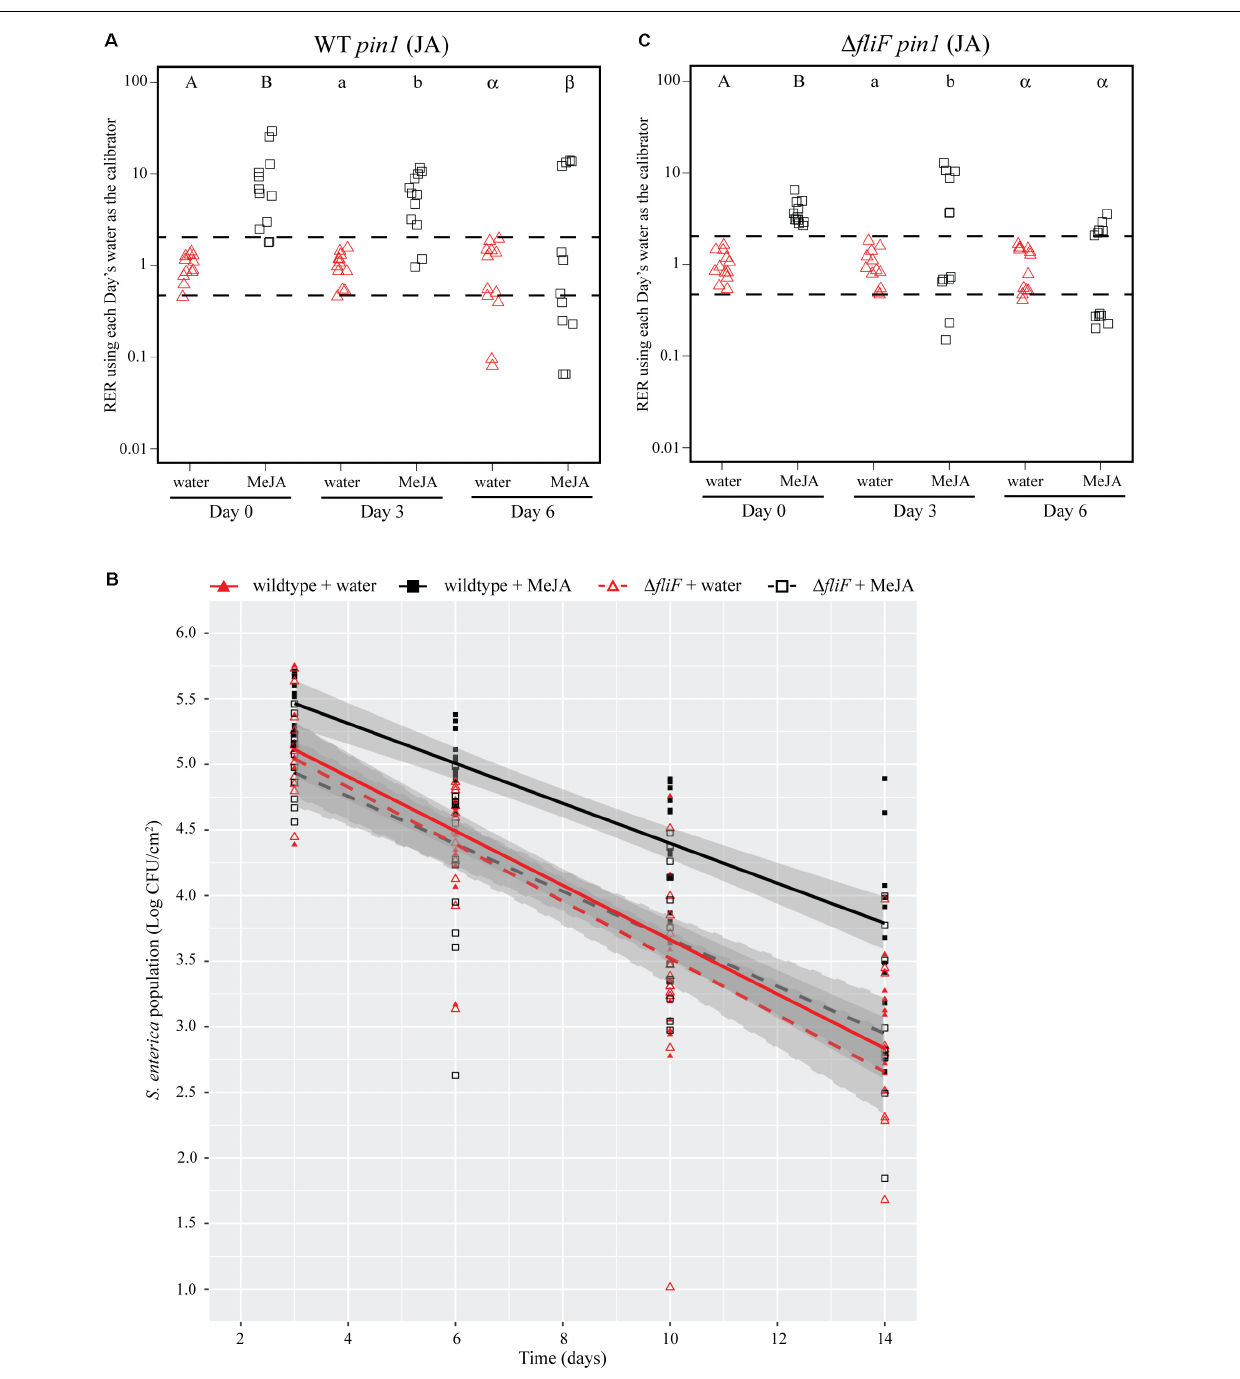
Frontiers in Microbiology |